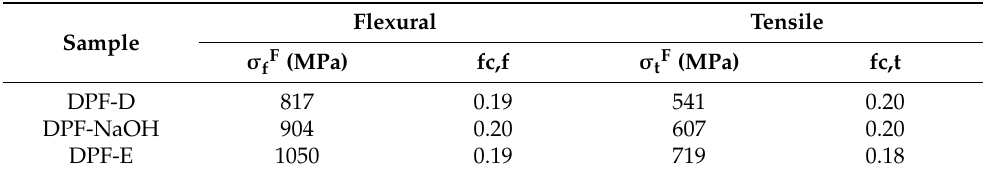
Table 5. Mean intrinsic tensile fiber strength, flexural strength, and flexural and tensile coupling factors of the fibers.